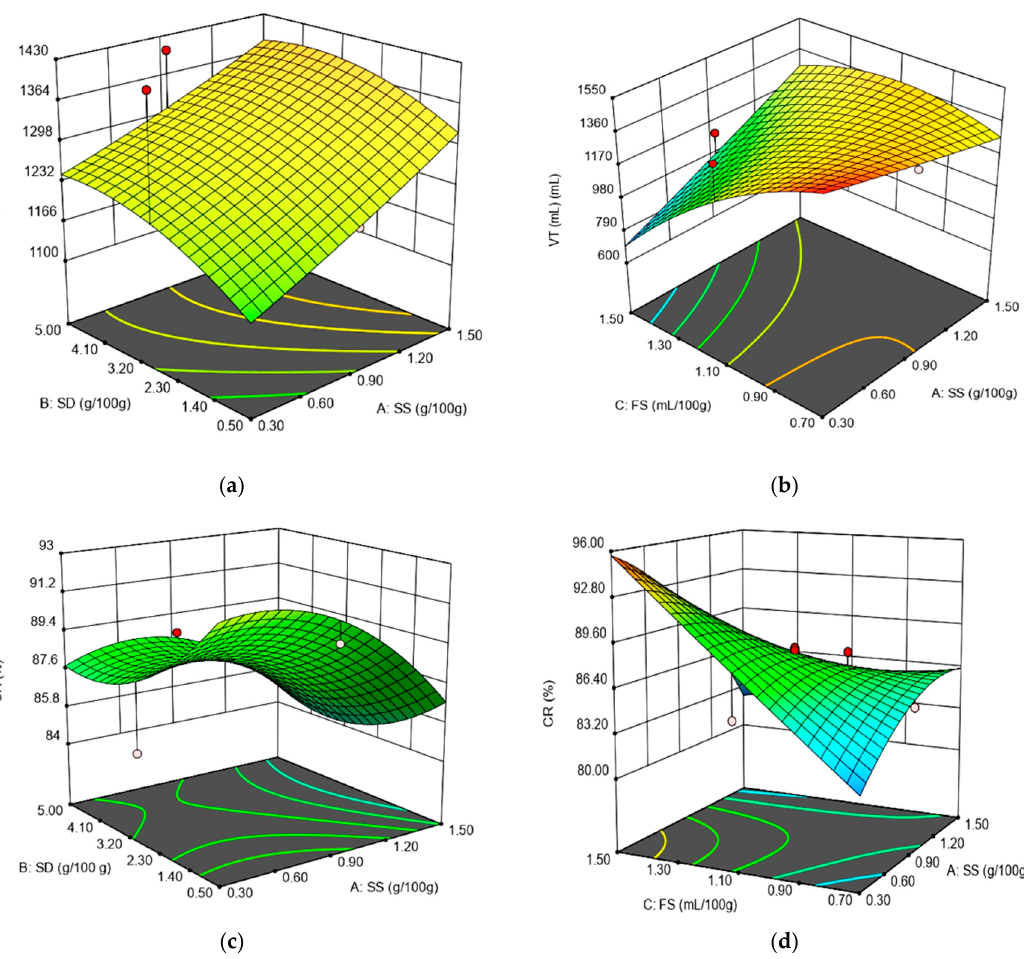
Figure 4. Graphical representations of the Rheofermentometer parameters: ( a ) total CO 2 volume production (VT) as affected by the levels of sea salt (SS) and dry sourdough (SD) incorporated in wheat flour at 1.10 (mL/100 g) fermented sugar; ( b ) total CO 2 volume production (VT) as affected by the levels of sea salt (SS) and fermented sugar (FS) incorporated in wheat flour at 2.75 (g/100 g) dry sourdough; ( c ) retention coefficient (CR) as affected by the levels of sea salt (SS) and dry sourdough (SD) incorporated in wheat flour at 1.10 (mL/100 g) fermented sugar; ( d ) retention coefficient (CR) as affected by the levels of sea salt (SS) and fermented sugar (FS) incorporated in wheat flour at 2.75 (g/100 g) dry sourdough.